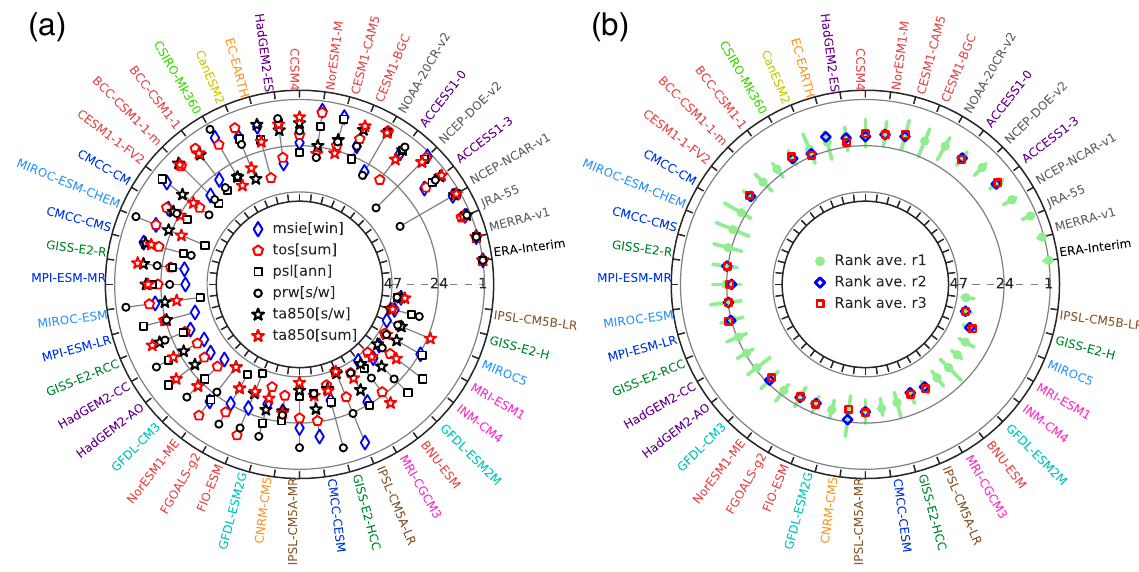
Figure 2. Model ranking according to CPI values: external circle is for rank 1 (ERA-Interim), while internal circle is for rank 47 (largest CPI). Models with obvious similarities in code or produced by the same institution are marked with the same colour (clusters), following Knutti et al. (2013). (a) Model rank for winter meridional sea-ice extent (msie[win], blue diamonds), summer sea surface temperature (tos[sum], red pentagons), annual sea-level pressure (psl[ann], black squares), summer/winter precipitable water (prw[s / w], black circles), summer/winter 850hPa air temperature (ta850[s / w], black stars), and summer 850hPa air temperature (ta850[sum], red stars). Models are ordered by the average of ranks. (b) Average of ranks for r1i1p1 (green dots), r2i1p1 (blue diamonds), and r3i1p1 (red squares) model realizations. When a field was not available for the second or the third realizations, we used the CPI value of the first realization for computing ranks. Green lines show variations of the average of ranks when using CPIs plus/minus multi-decadal variabilities for the considered model while not changing CPIs for other